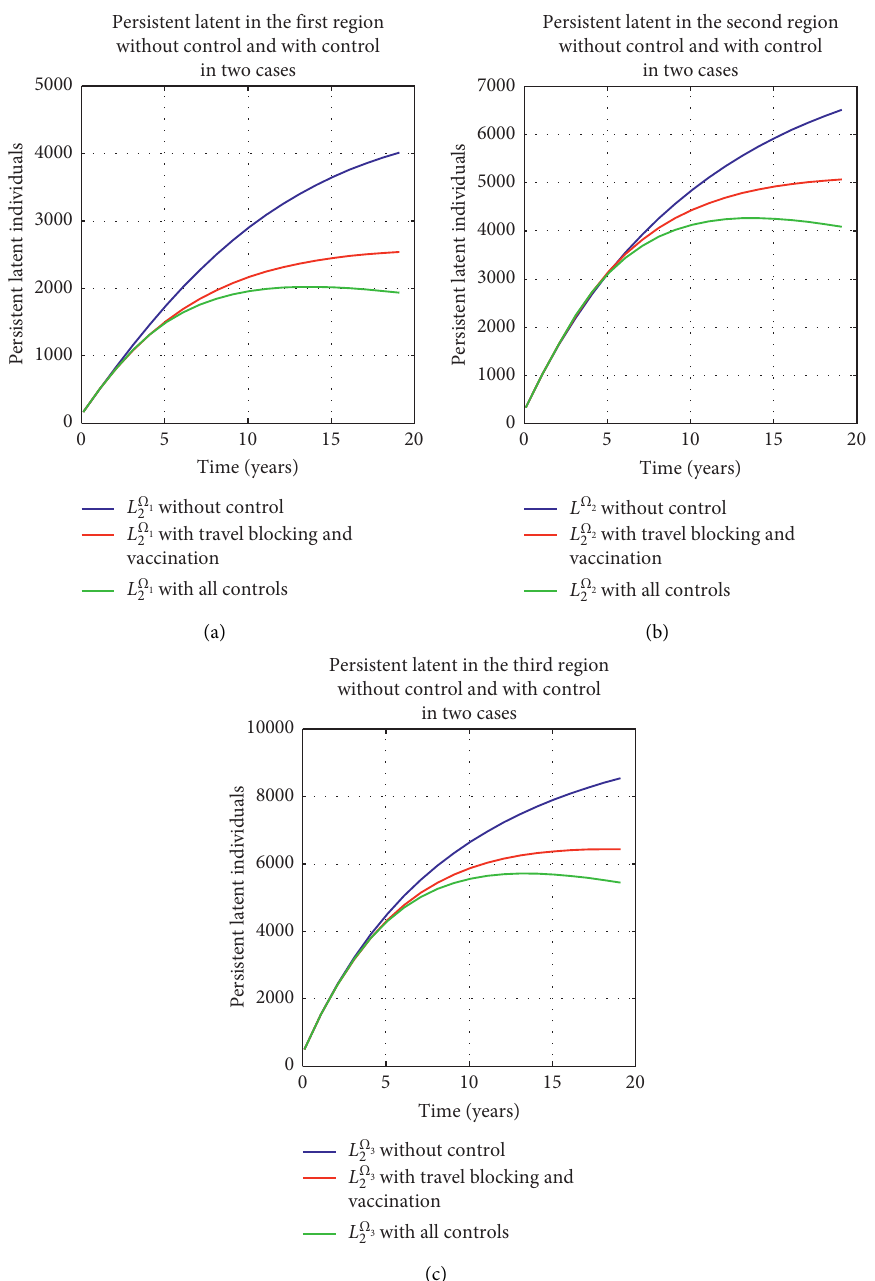
Figure 12: Comparison of the persistent latent in each region without control and with control in two